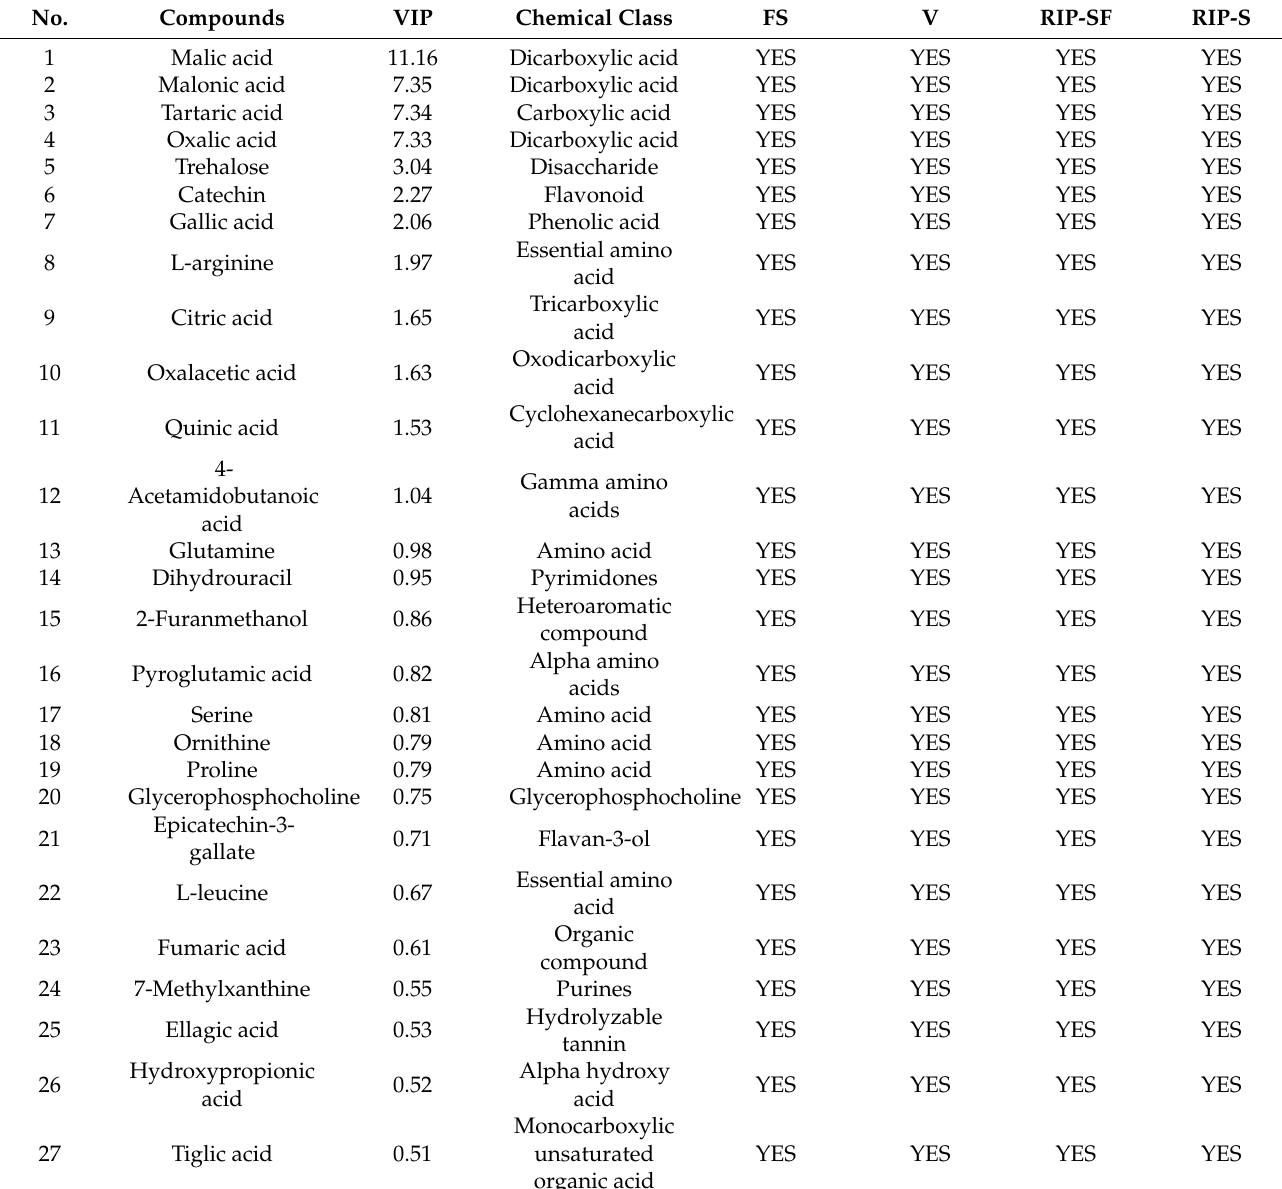
Table 1. Candidate metabolites (VIP > 0.5) of muscadine grape genotypes at selected developmental stages. No.